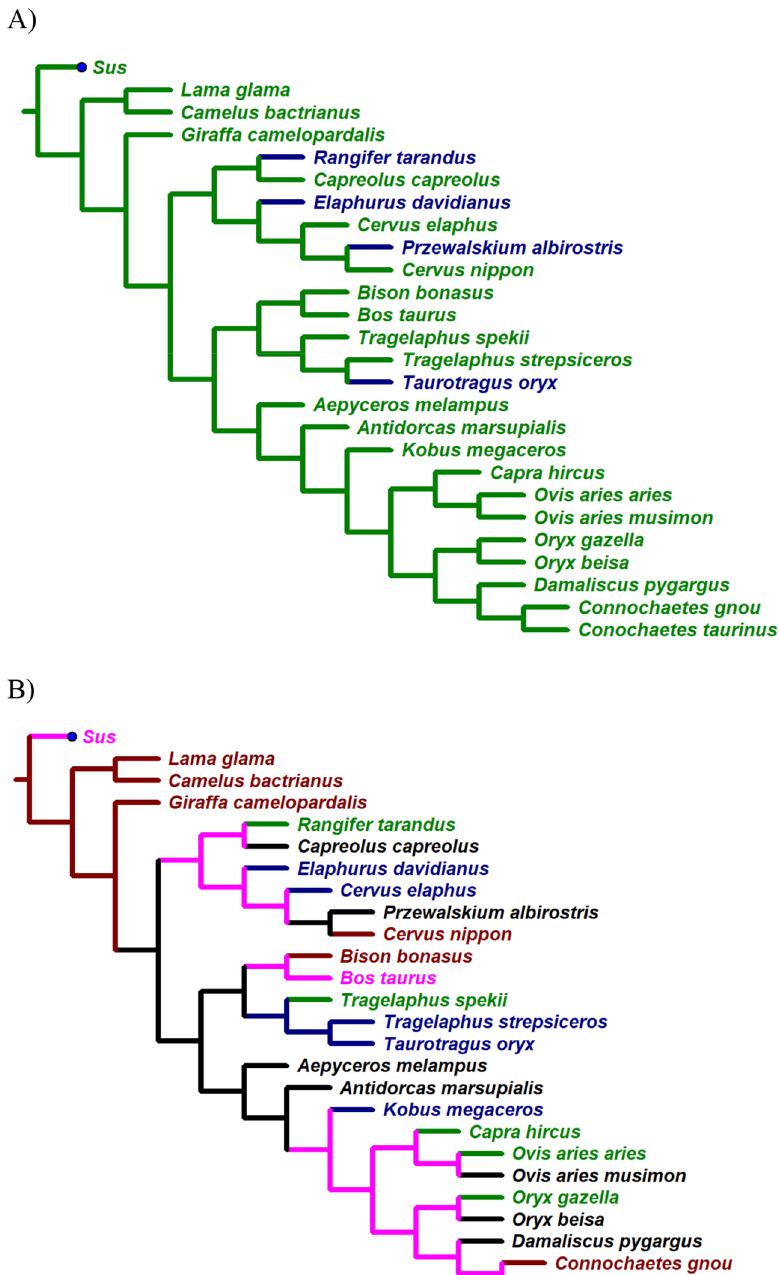
Figure 4. Evolution of knee-clicks ( A ) and OWMF length–width ratio ( B ) as reconstructed by the maximum parsimony approach. For more details see the body of text. Legend to ( A ): no knee-click in repertoire = green, knee-click present = blue. Legend to ( B ): type 1 of OWMF = green, type 2 = blue, type 3 = black, type 4 = brown, unresolved =